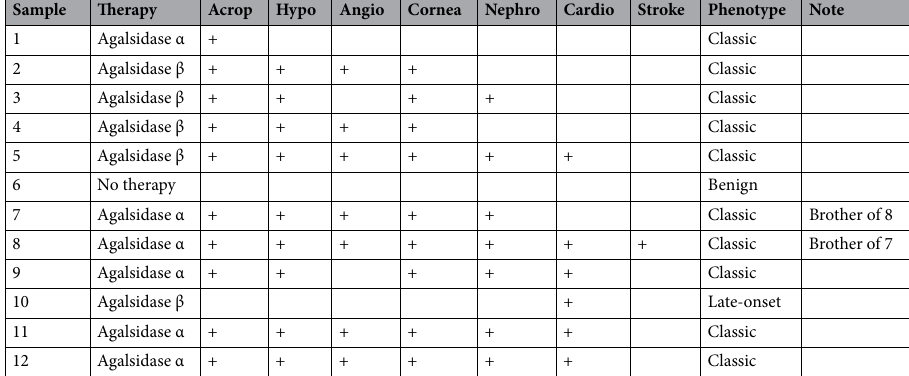
Table 1. Clinical presentation of the cohort of Fabry patients. Acrop acroparesthesia, Hypo hypohidriosis, Angio angioceratoma, Cornea cornea verticillata, Nephro nephropathy, Cardio cardiomyopathy, Stroke history of